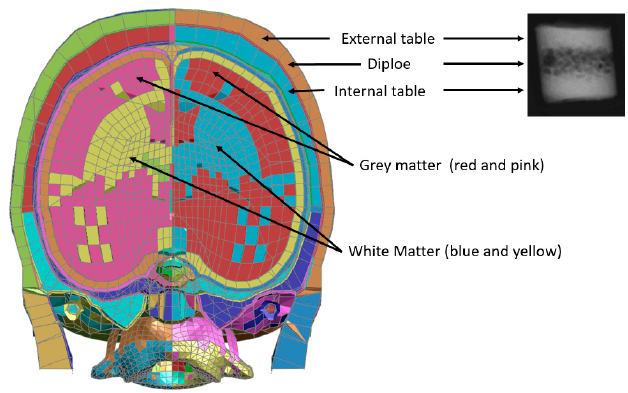
Figure 2. Cross-section of the skull (THUMS [26] vs. in a human specimen [30,32]).